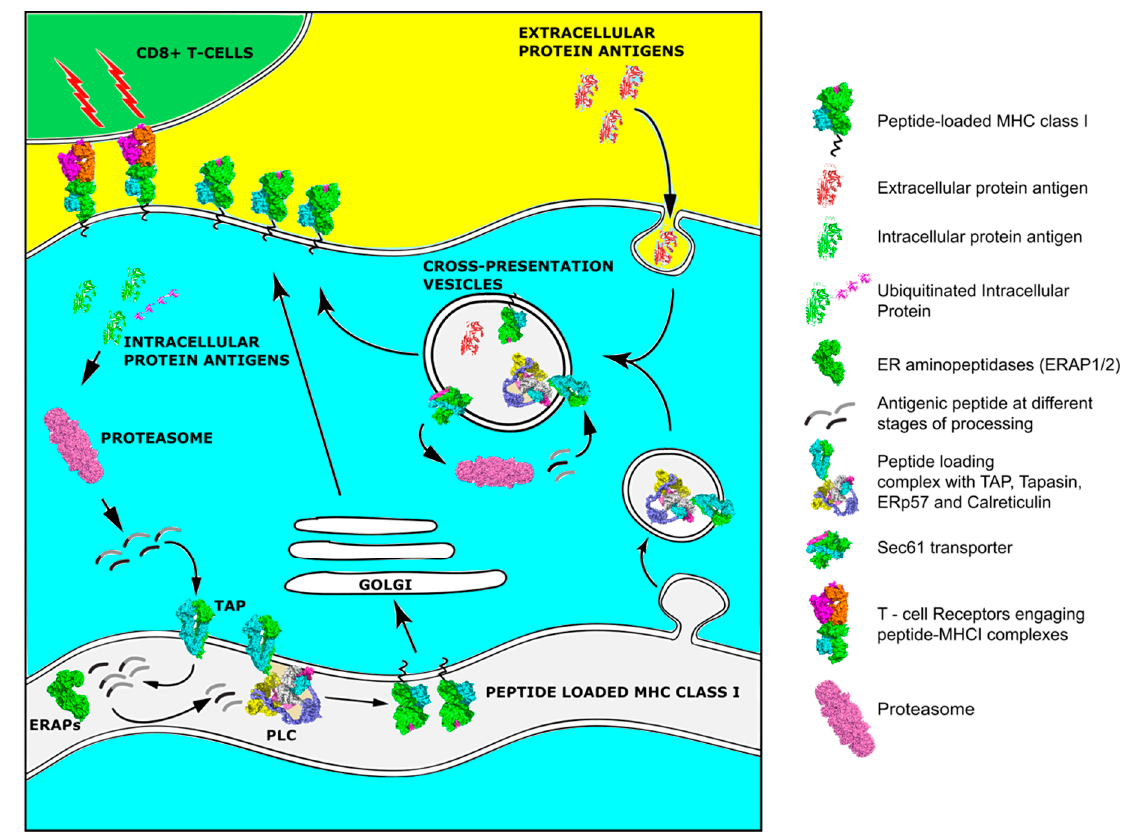
Figure 1. Overview of the Major Histocompatibility Class (MHC) class I pathway of antigen processing and presentation and the alternative pathway of cross-presentation.